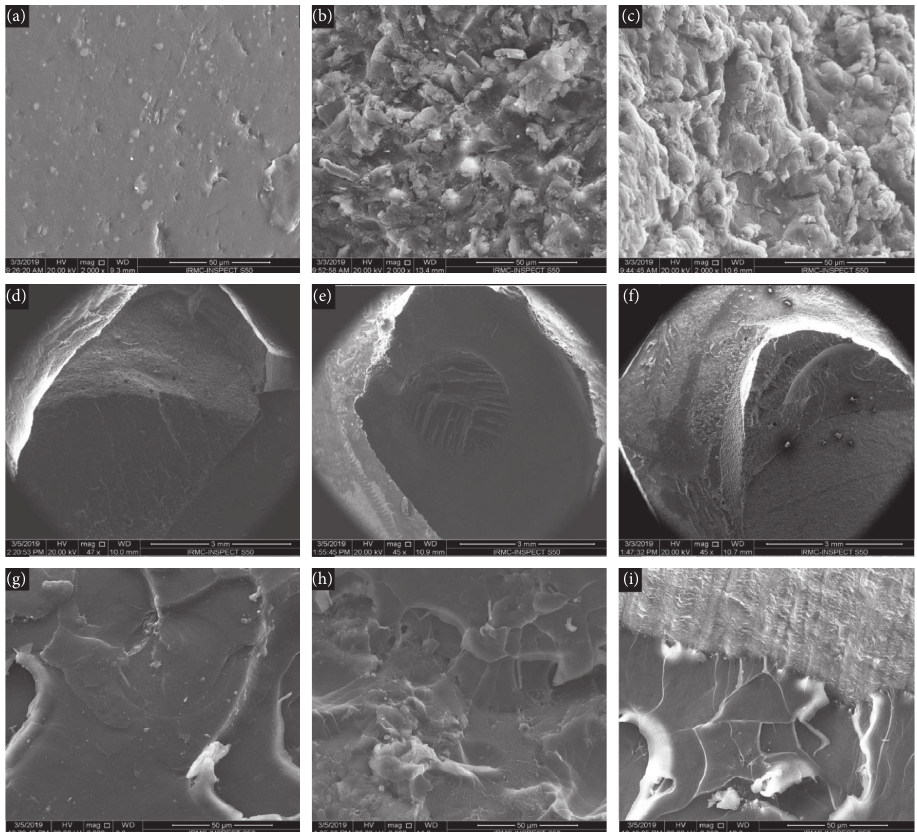
Figure 2: Representative SEM images showing (a) surface treatment effect on the control specimen before repair; (b) effect of AB surface treatment on the specimen before repair; (c) effect of AB +SCA surface treatment on the specimen before repair; (d) brittle fracture of the control specimen; (e) ductile fracture of the AB-treated specimen; (f) ductile fracture of the AB +SCA-treated specimen; (g) adhesive failure of the control specimen; (h) cohesive failure of the AB-treated specimen; (i) mixed failure of the AB+SCA-treated